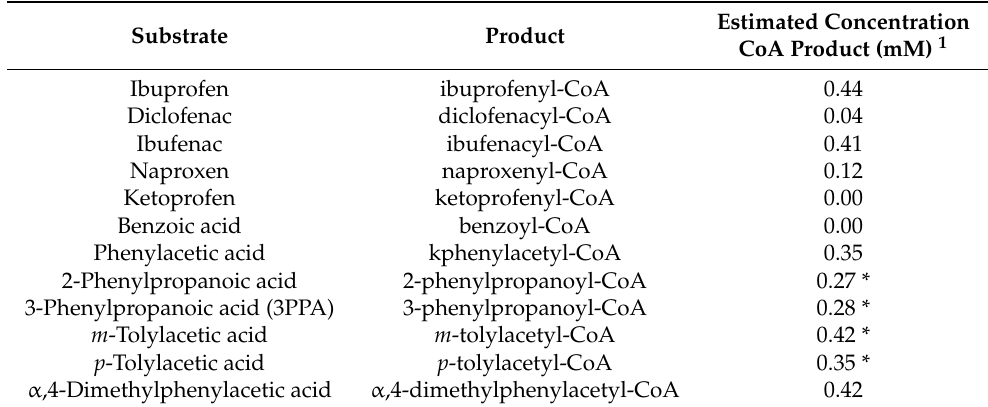
Table 1. Conversion of 0.5 mM substrate by IpfF, a CoA